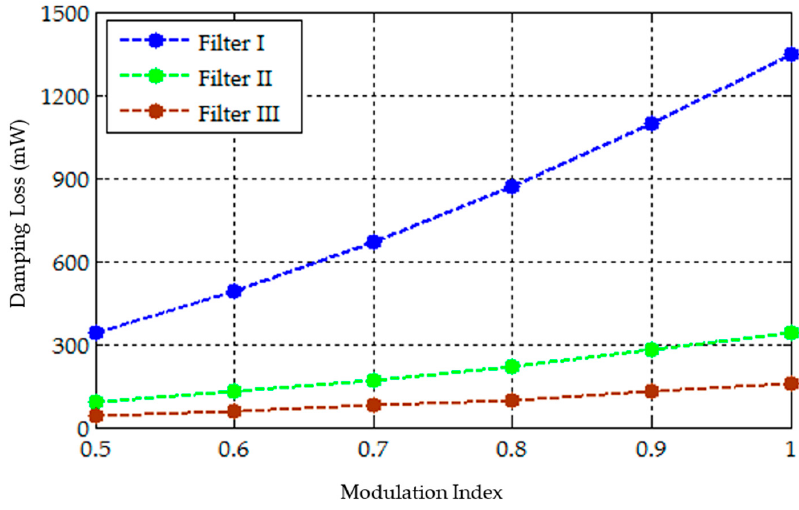
Figure 6. Damping loss for different modulation index values.